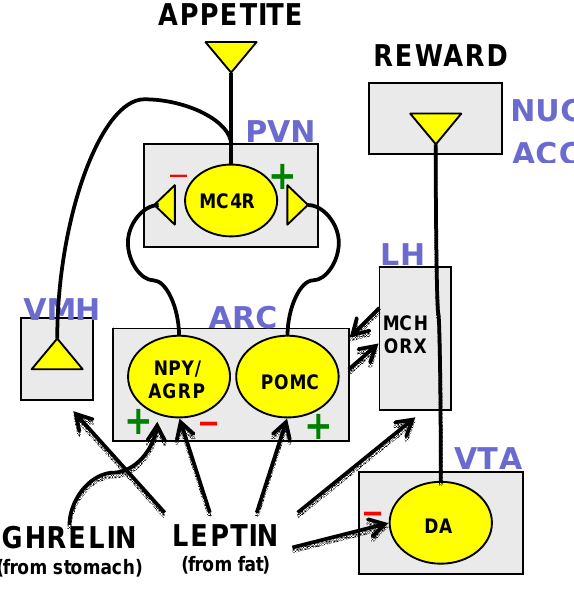
Figure 1. The core hypothalamic energy homeostatic circuit and the dopamine reward pathway. Neuronal subtypes expressing neuropeptide-Y and agouti related peptide (NPY/AGRP), proopiomelanocortin (POMC), the melanocortin-4 receptor (MC4R) and dopamine (DA) are in yellow. Rectangles indicate various anatomical loci: ARC = arcuate nucleus, PVN = paraventricular nucleus, VMH = ventromedial hypothalamus, LH = lateral hypothalamus, VTA = ventral tegmental area, NUC. ACC. = nucleus accumbens.